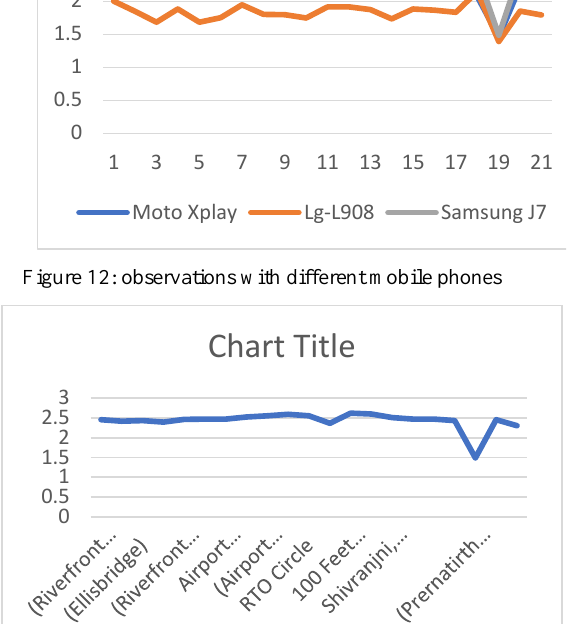
Figure 16: Clear sky with Turbidity